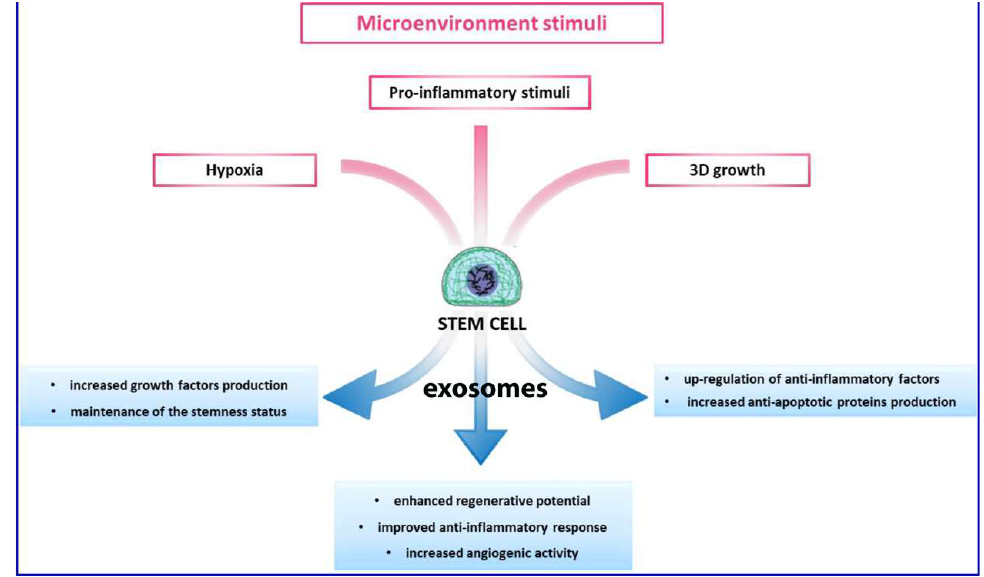
Figure 5. Different modes of action of